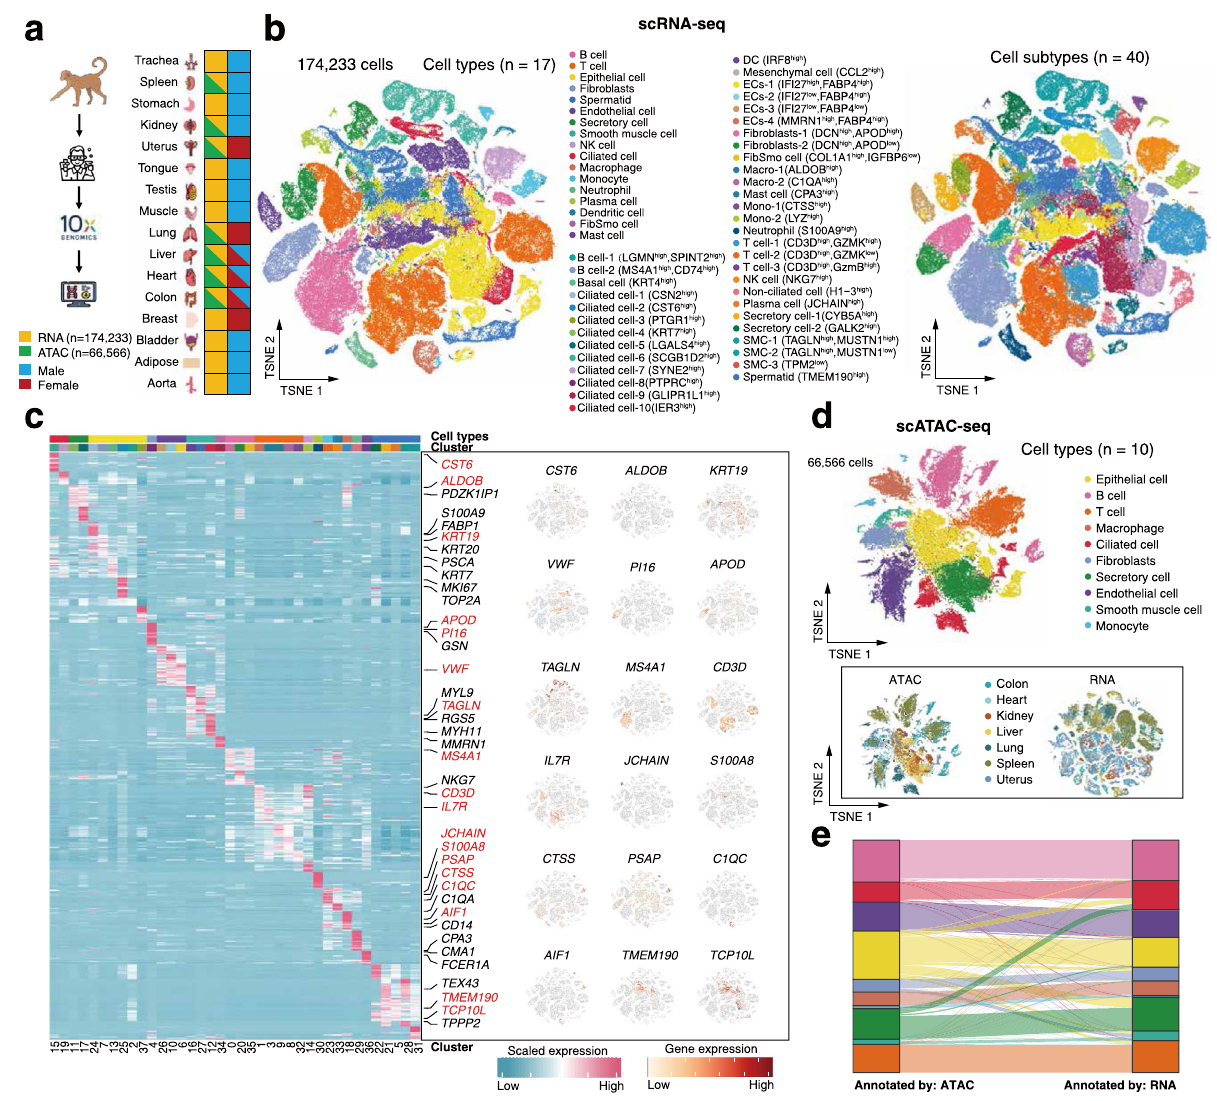
Fig. 1 Single-cell landscapes across 16 organs in cynomolgus monkeys. a Schematic illustration of the work fl ow. Single-cell transcriptome (scRNA-seq) analysis was conducted in 16 organs and chromatin accessibility (scATAC-seq) analysis in seven organs from adult cynomolgus monkeys. b Cell type identi fi cation based on scRNA-seq data. In total 17 major cell types and 40 cell subtypes were identi fi ed. T-SNE visualizations of cells were colored either by the major cell types (left) or by the cell subtypes (right). c Heatmap showing the scaled expression levels of cell type-speci fi c marker genes (left). Expression patterns of 18 representative marker genes are shown on the right. d T-SNE illustration of cell type annotation based on scATAC-seq data analysis. Ten major cell types were identi fi ed from 66,566 cells. Cells were colored by major cell types (the top panel) or by organs (bottom left) in the t-SNE plots. The bottom right t-SNE plot shows the clustering of cells based on scRNA-seq data for the seven organs with matched RNA-ATAC samples. e Sankey diagram showing the consistence of cell type annotations between scRNA-seq and scATAC-seq data. Only the seven organs with matched RNA- ATAC data were used for the analysis. The color code refers to ( d